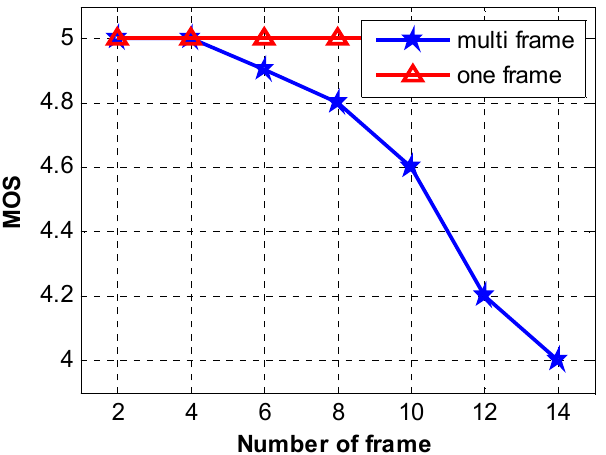
Figure 6. Subjective test results for different number of frames.